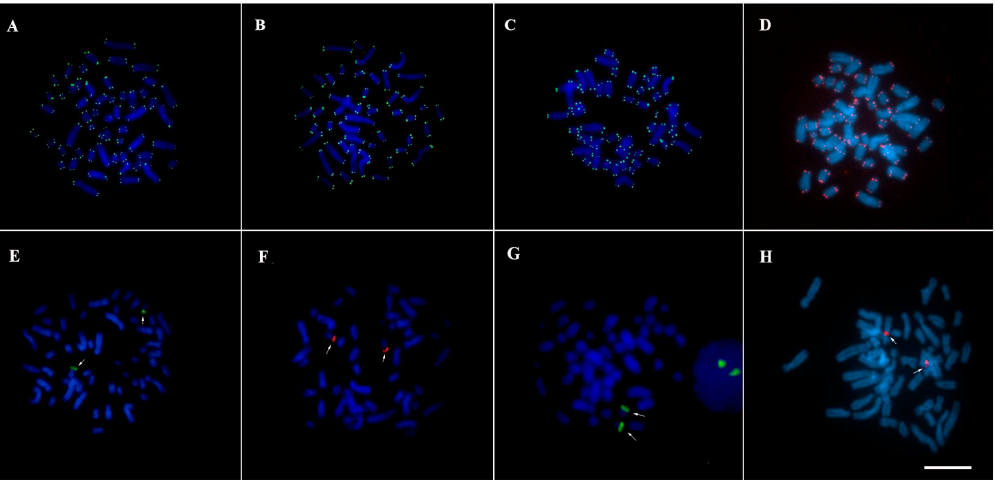
Figure 4. Fluorescent in situ hybridization with probes of telomeric sequences ( A – D ) and 45S rDNA ( E – H ): ( A , E ) T. inunguis ; ( B , F ) T. m. manatus ; ( C , G ) “Poque”; and ( D , H ) “Vitor”. Bar 10 μ m.